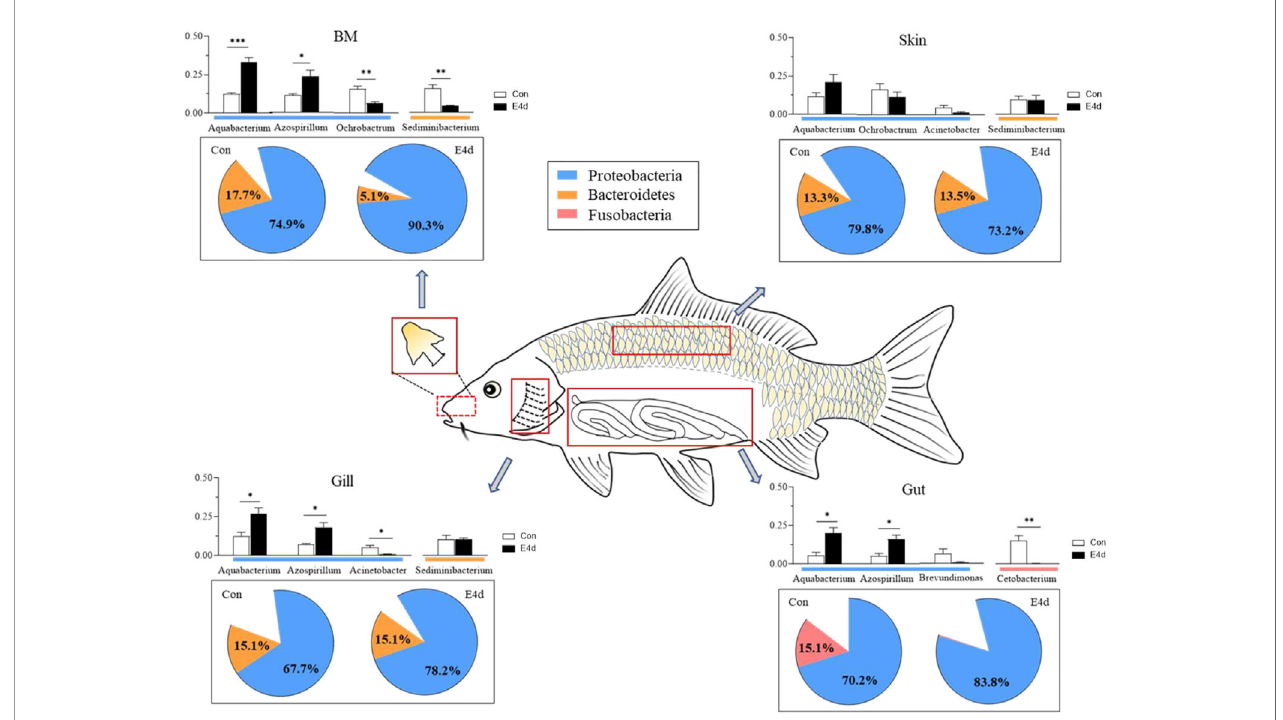
FIGURE 7 | A map of microbiome community compositions at different mucosal sites (BM, gills, skin, and gut) in common carp after SVCV infection. The pie charts represent the microbial changes at the phylum level following SVCV infection. The histograms represent the changes of dominant bacteria abundance at the genus level following SVCV infection. Red rectangles show the sampling scheme used for 16S sequencing. * P < 0.05, ** P < 0.01, *** P < 0.001, unpaired Student ’ s t -test. E4d, 4 days after SVCV